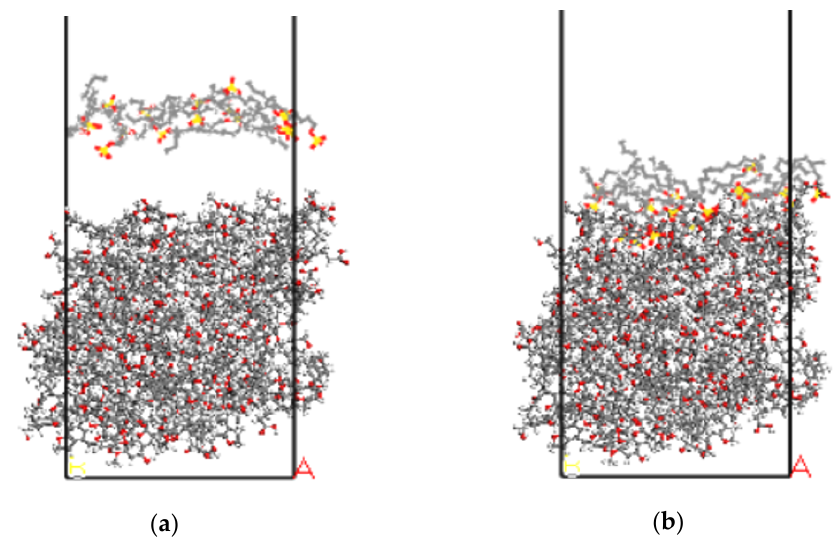
Figure 3. Initial ( a ) and final ( b ) adsorption configurations of SDS-lignite system.